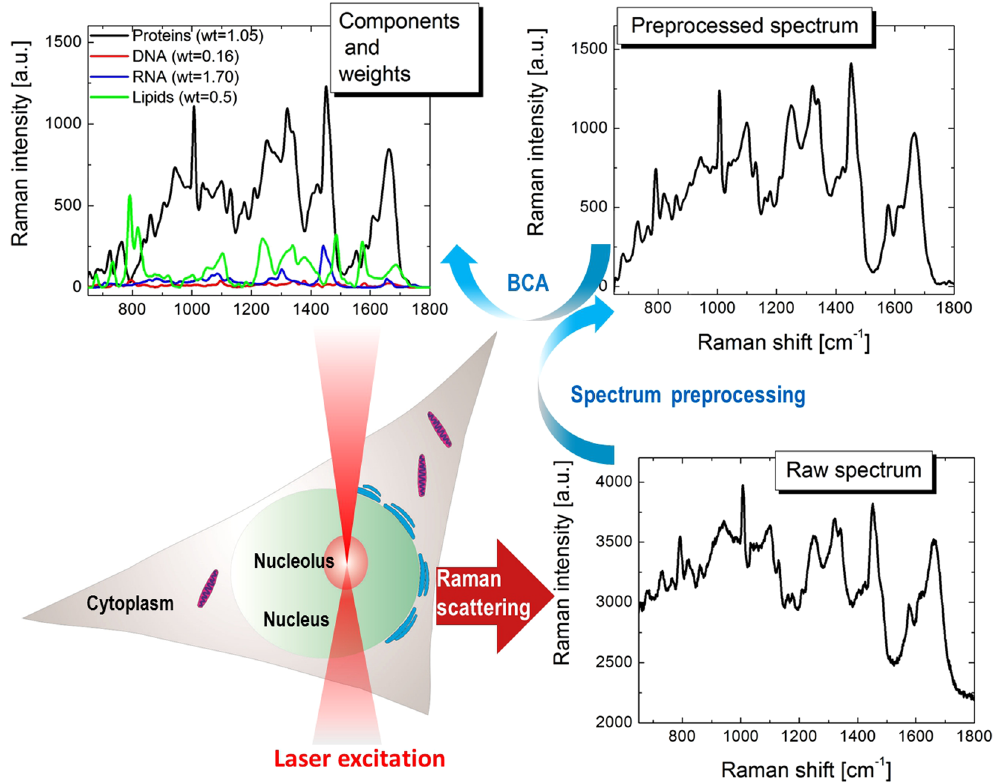
Figure 1. Schematics of microRaman-BCA approach for molecular profiling of cellular organelles: measurement of organelle’s spectrum, preprocessing and decomposition of spectrum to biomolecular components with concentration weights (proteins, DNA,RNA,